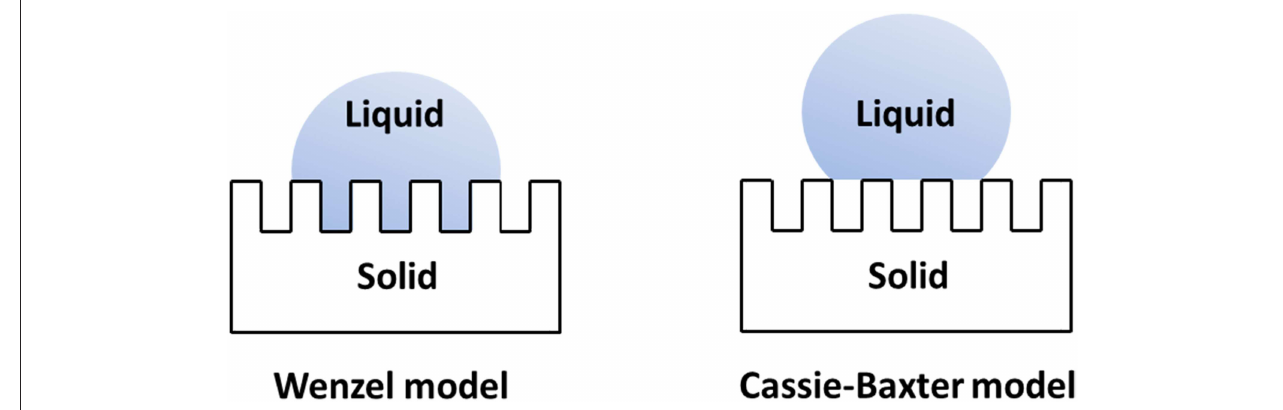
FIGURE 2 | Wenzel and Cassie–Baxter